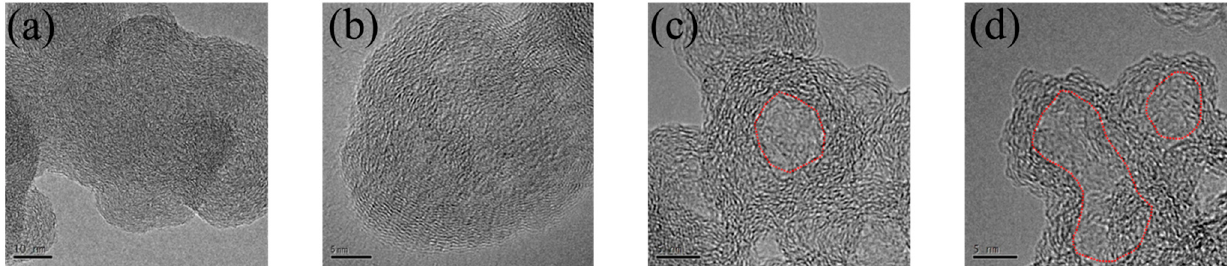
Figure 9. Microstructure of soot particles with different oxidation rates of ( a ) 0%, ( b ) 56.1%, ( c ) 71.2%, ( d ) 89.4%.